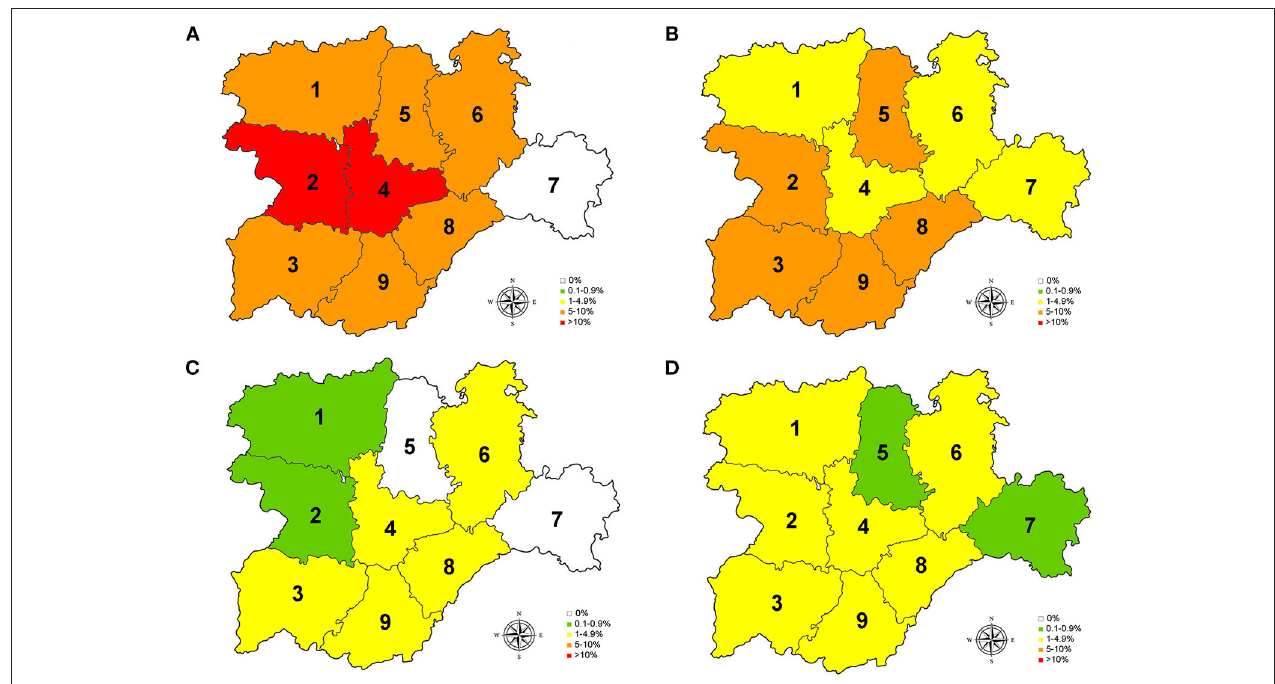
FIGURE 2 | Prevalence for D. immitis (A) , and seroprevalences for L. infantum (B) , A. platys (C) , and E. canis (D) in the nine provinces of Castilla y León, Spain. 0% ( • ); 0.1–0.9% ( ); 1–4.9% ( ); 5–10% ( ); > 10 ( ).1, León; 2, Zamora; 3, Salamanca; 4, Valladolid; 5, Palencia; 6, Burgos; 7, Soria; 8, Segovia; 9, Ávila.